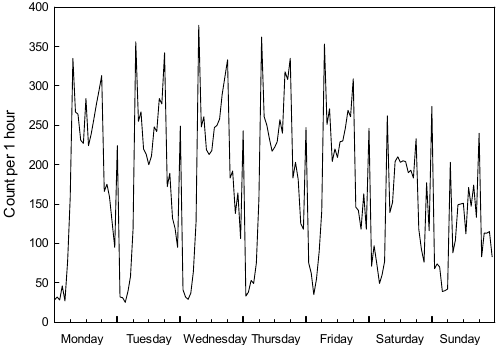
Figure 5. The periodicity trend of parking occupancy for the interval of 60 min in a week.